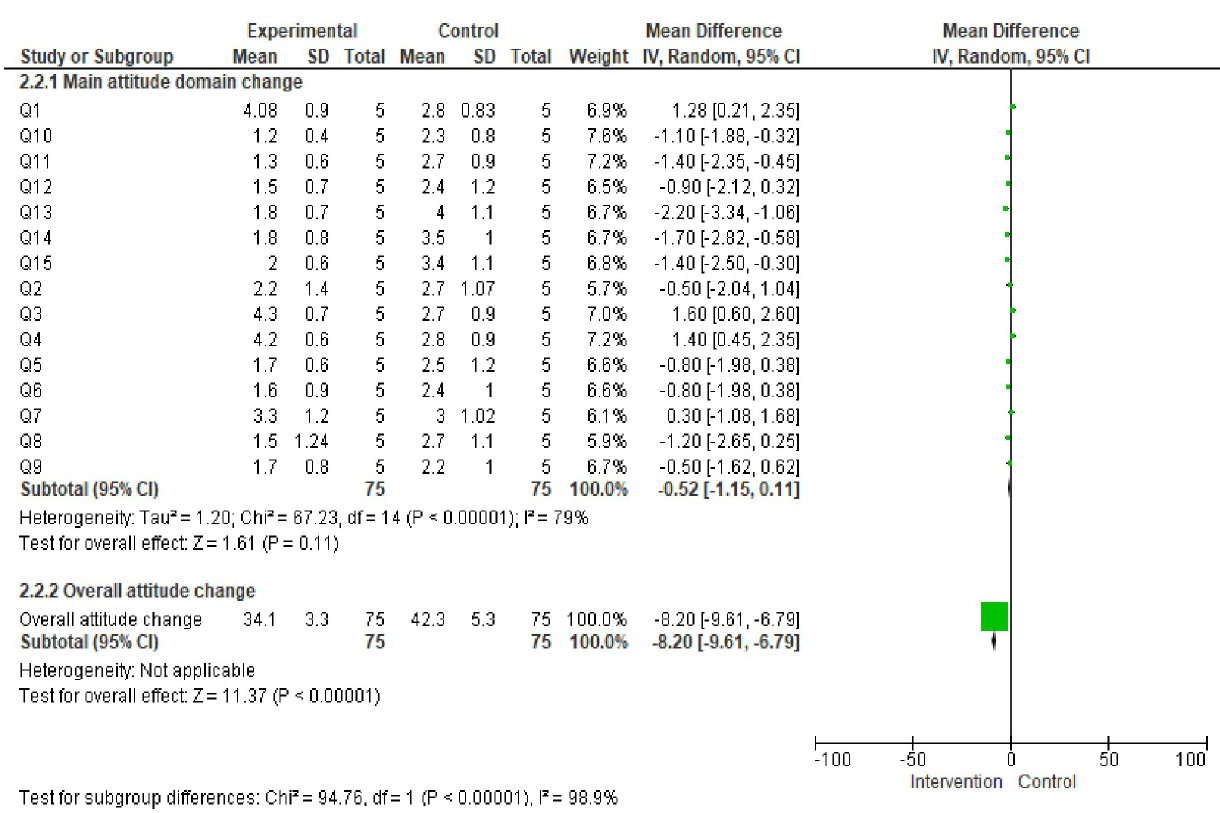
Fig 3. Frost plot of change of main domain of attitude of post graduate students in Ethiopia